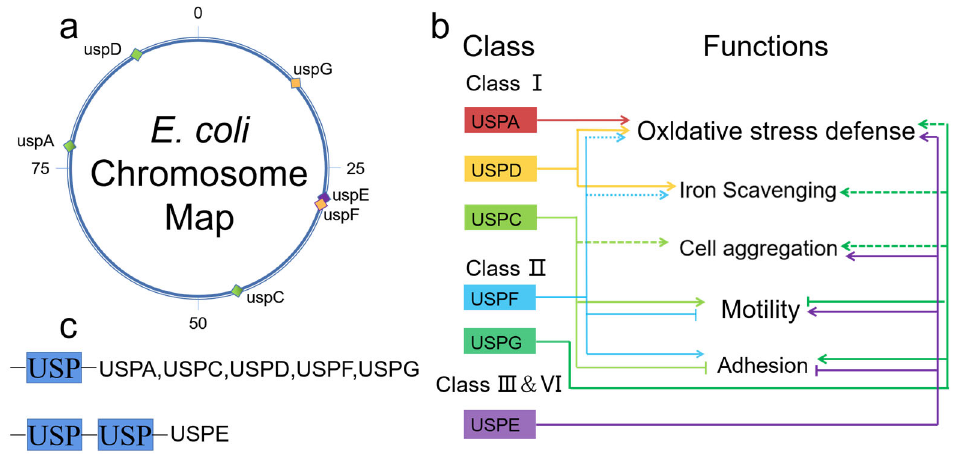
Figure 1. E. coli genes and functions. ( a ) Location of USP family genes on E. coli chromosomes. uspA, uspC and uspD belong to a category represented by green squares, uspF and uspG belong to another category represented by yellow squares, and uspE is represented by purple; ( b ) the role of six E. coli USPs in oxidative stress defense, iron metabolism, and cell surface properties; ( c ) classification of universal stress proteins of E. coli.